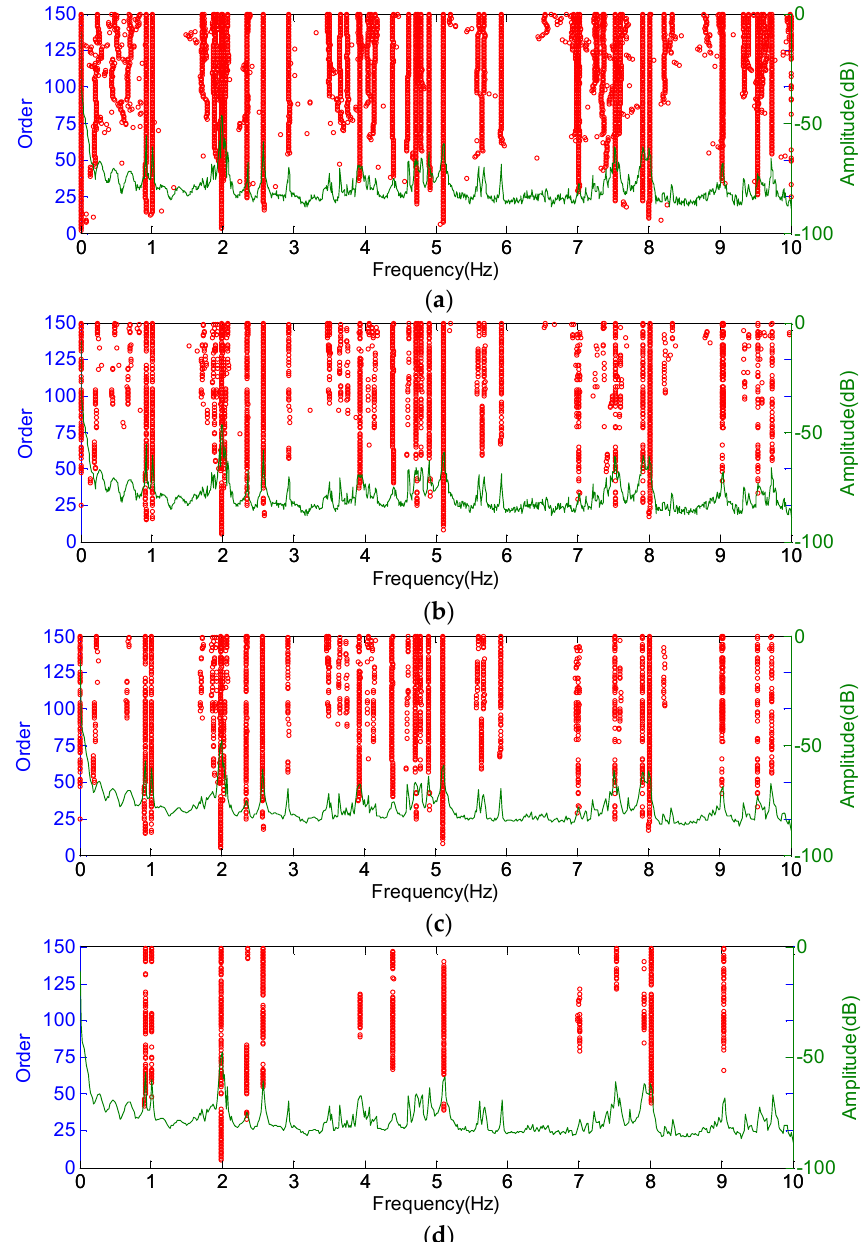
Figure 3. Original stabilization diagram, cleaned stabilization diagram, and stabilization diagram, after the elimination of noise poles by DBSCAN: ( a ) original stabilization diagram; ( b ) cleaned stabilization diagram; ( c ) stabilization diagram, after the removal of noise poles by applying the DBSCAN procedure only to frequency; and ( d ) stabilization diagram, after removing noise poles by applying the DBSCAN procedure to modal frequency, modal damping, and modal shape.